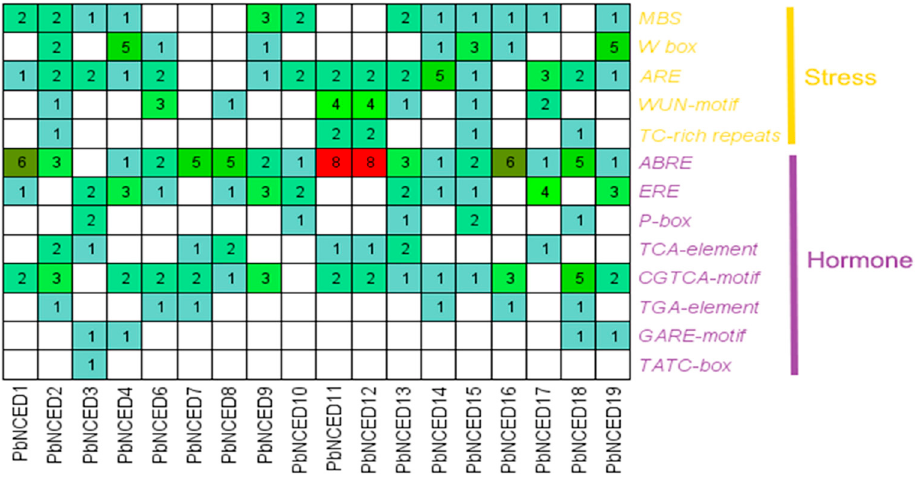
Figure 5. Protein interaction network of PbNCEDs constructed by referring to AtNCEDs . Note: The names of pear homologous proteins are highlighted in red.